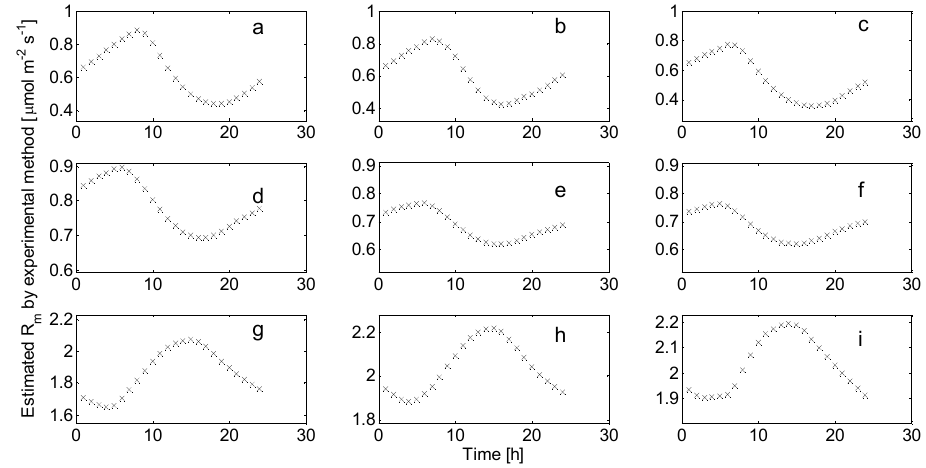
Figure 5. Isolated R m by experimental method ( a – c : saline desert; d – f : abandoned farmland; g – i : oasis farmland).